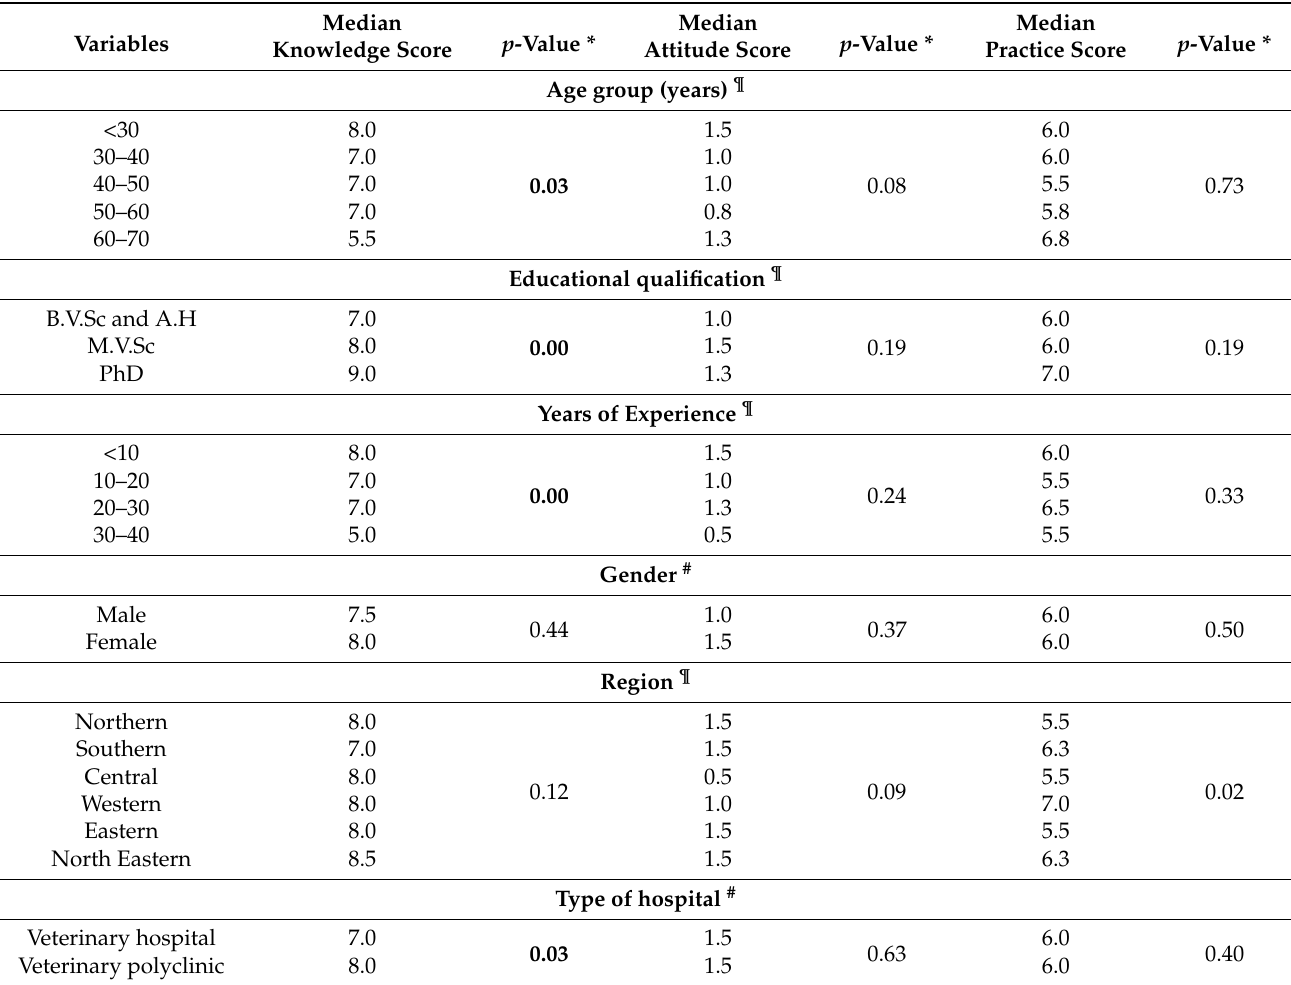
Table 3. Demographic characteristics and associated KAP